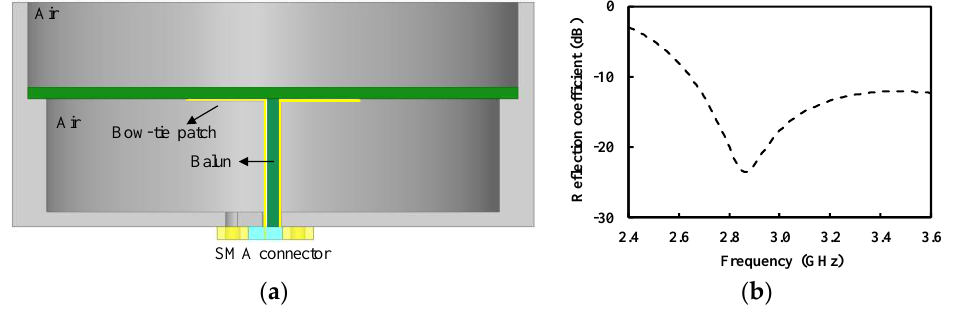
Figure 4. Cavity-backed bow-tie antenna with balun ( a ) cross-sectional view; ( b ) simulated reflection coefficient.